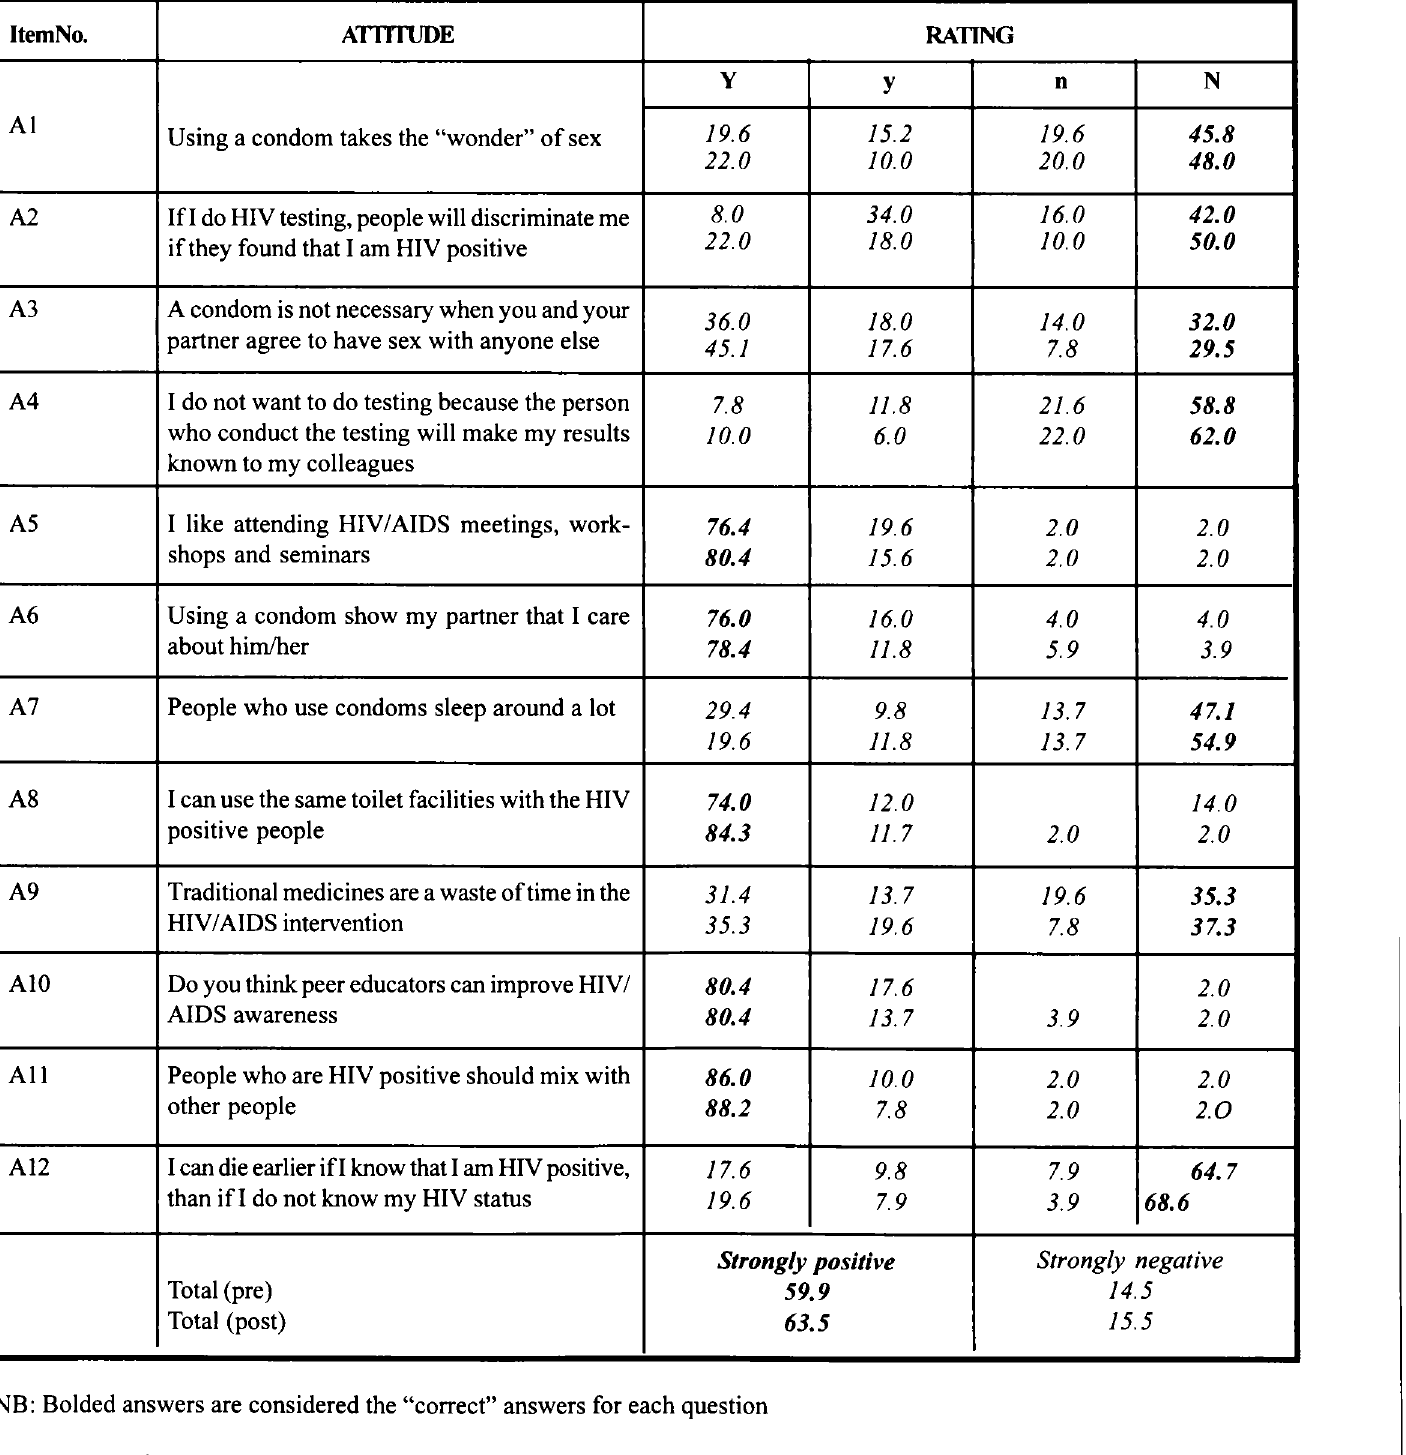
Table 5: Percentage on attitude before and after HIV/AIDS awareness workshop